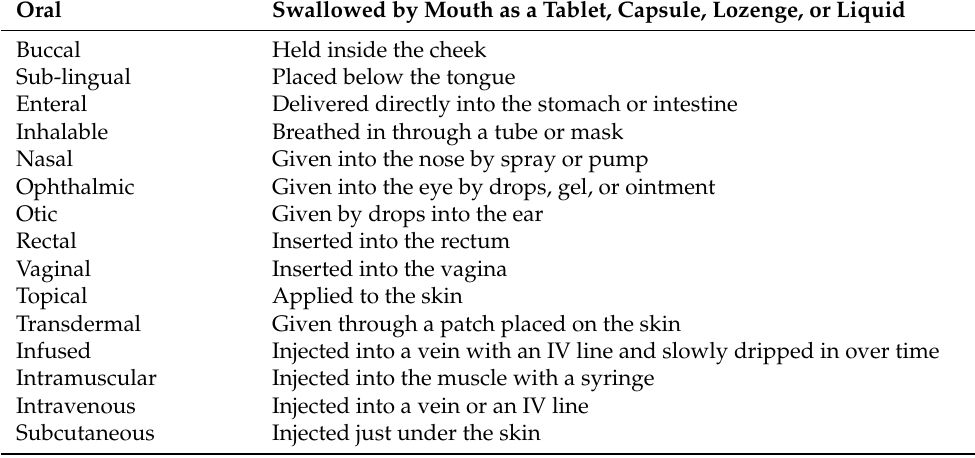
Table 1. Routes of drug